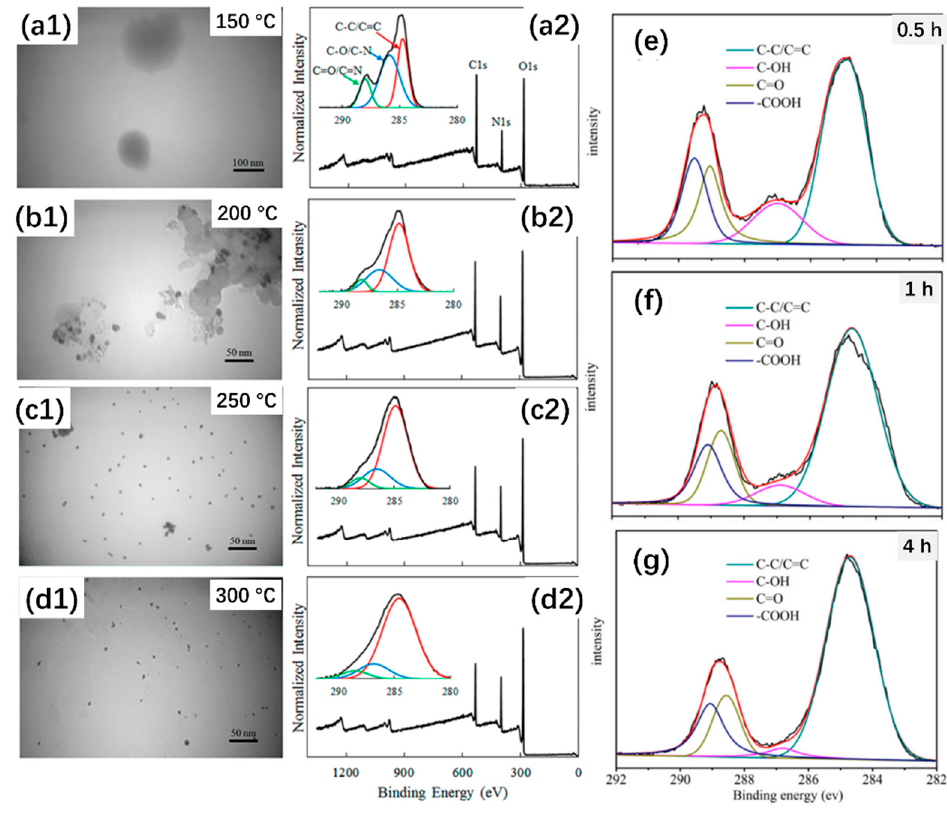
Figure 4. ( a1 – d2 , Ref. [48]) TEM images and high-resolution XPS spectra of C1s of CDs prepared at different temperatures. ( e – g , Ref. [49]) The high-resolution XPS spectra of C1s of CDs were prepared with different reaction times. Adopted from Ref. [48,49] with permission of Copyright (2018) American Chemical Society and Copyright (2018) Elsevier.